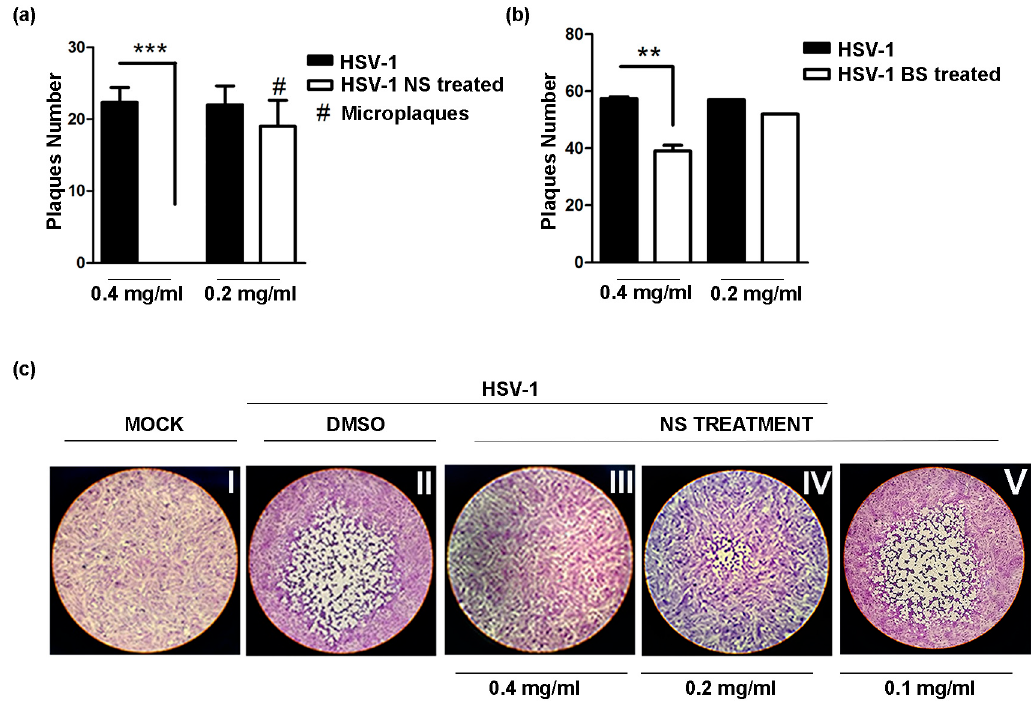
Figure 3. Plaque reduction assay to verify the antiviral activity of Californian natural and blanched skin almond extracts: Vero cells were infected with HSV-1 (F) and incubated for 1 h at 37 °C. After the incubation time, the inoculum was removed, and the monolayers were overlaid with Dulbecco’s Modified Eagle’s Medium containing 0.8% methylcellulose in the presence of NS and BS extracts at different concentrations (0.4 mg/mL, 0.2 mg/mL and 0.1 mg/mL). The plates were incubated at 37 °C and 5% CO 2 for three days, and the plaques were visualized by staining cells with crystal violet. The DMSO was used in the HSV-1 control. Results are the mean ± SD of triplicate experiments, and * indicates significant changes ( p -value ≤ 0.001). In ( A , B ), the plaque reduction assay was performed following NS and BS almond extracts treatment, respectively. ( C ) Shows the plaque morphological change due to NS treatment 0.4 mg/mL vs. 0.2 mg/mL. No reduction was observed at 0.1 mg/mL.